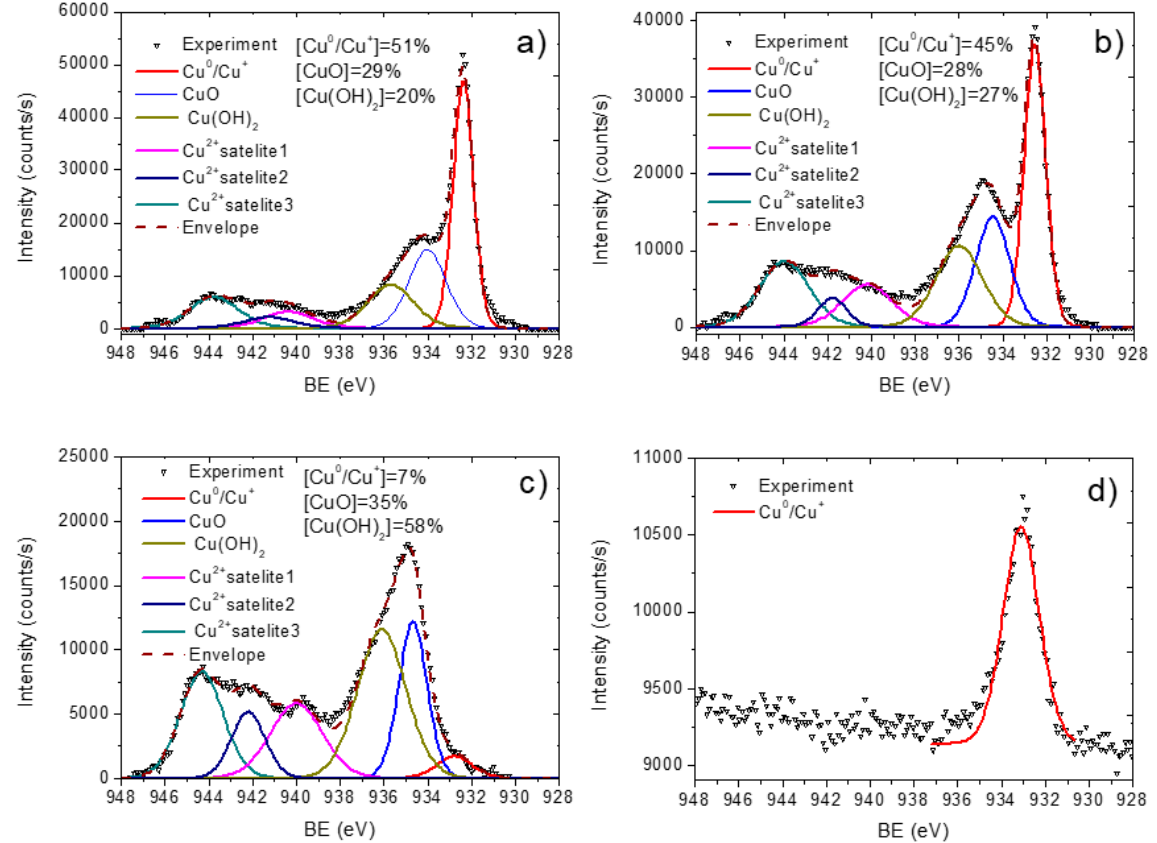
Figure 6. XPS Cu2p curve fitting of PCL-Cu as deposited ( a ), after 2h in PBS ( b ), after 24 h in PBS ( c ) and PCL-Cu-COOH ( d ).